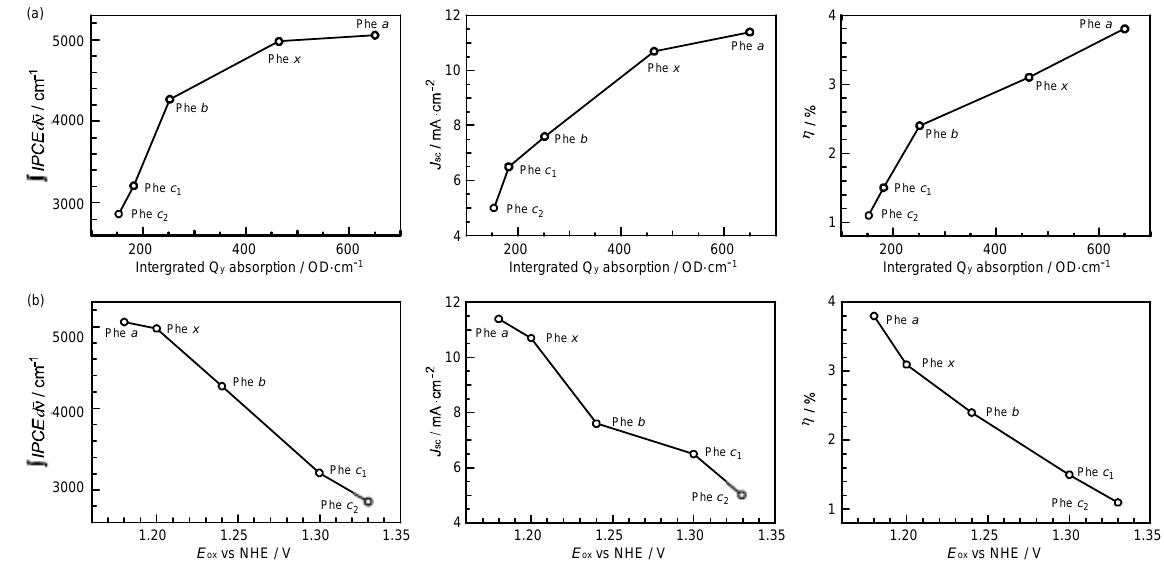
Figure 35. (a) The integrated IPCE ( d IPCE ν ∫ ), the photocurrent ( J efficiency ( η ) as functions of (a) the integrated Q ) for the solar cells using the Phe a , Phe x , Phe b , Phe c oxidation potential ( E ox sensitizers (reprinted with permission from [20] © 2008, American Chemical